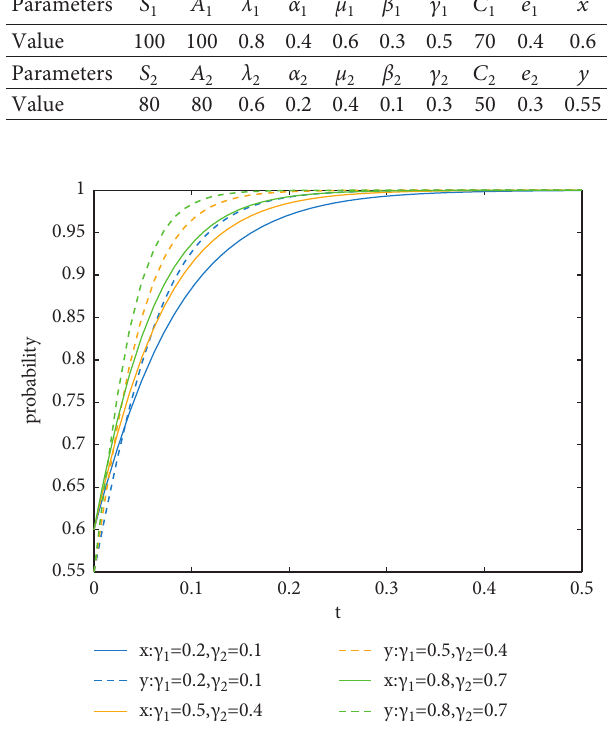
Figure 5: The effect of knowledge leakage risk on knowledge